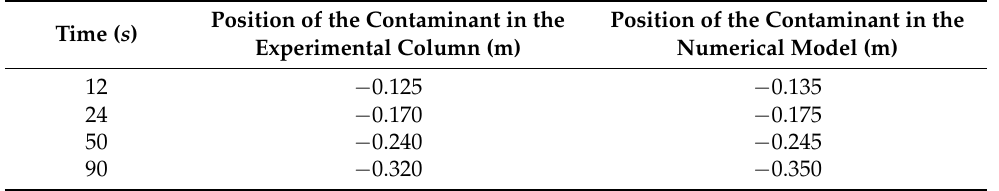
Table 2. Values of the position of the contaminant migration in the column experiment, and in the numerical model output, for different